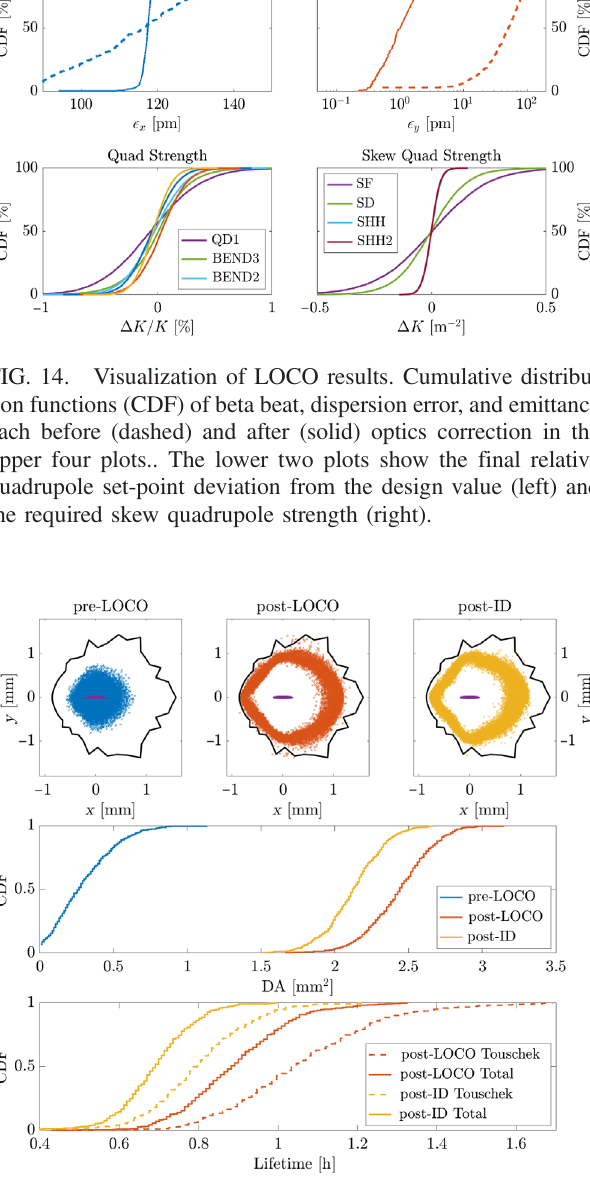
FIG. 15. DA (top and center) and lifetime (bottom). The comparison is between before (blue) and after (red) performing optics correction, and after including and compensating for the IDs (yellow). In the upper images, the solid curve is the ideal lattice DA, and the purple ellipses indicate the injected beam size ( 3 σ ). In the bottom image, the dashed curves are the CDF for the Touschek lifetime only; the solid curves are the CDF for the total beam lifetime (Touschek and